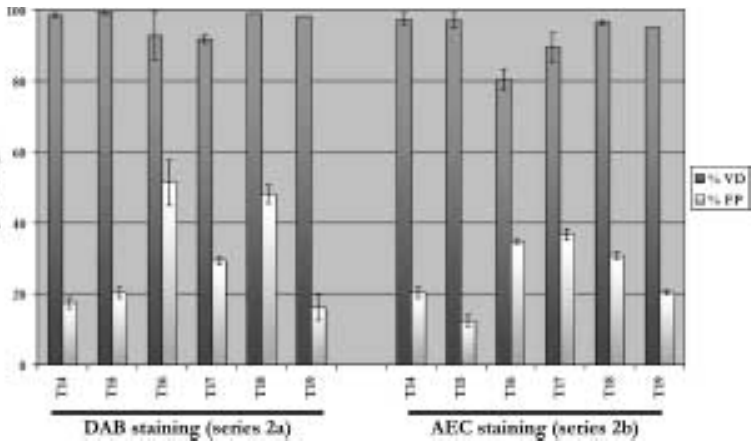
Fig. 7. Comparison of results obtained with DAB and AEC as chromogens. Both chromogens were used with the amplified immunostaining procedure. Well detected vessel (%VD) and false-positive (%FP) rates were determined for each image.